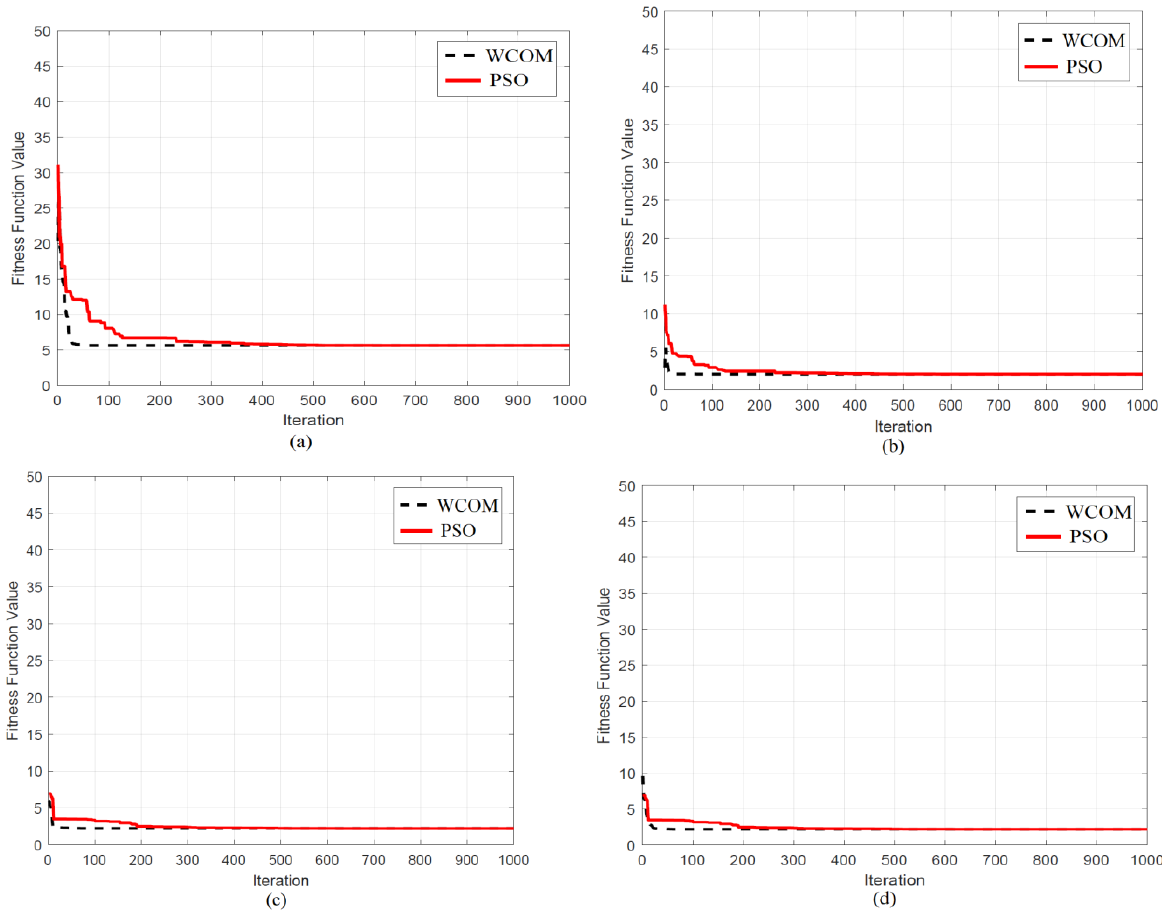
Table 8. The results of WCOM and PSO algorithms in OOT and elapsed time in Mode 1 and 2.